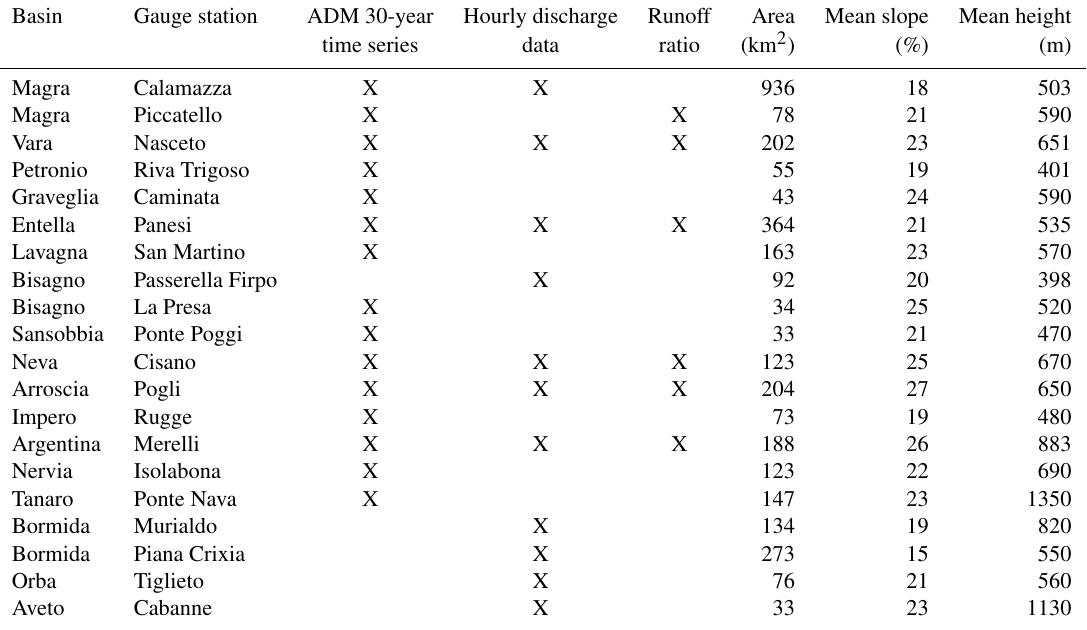
Table 1. Availability of discharge data used for model validation, ADM analysis, and long-term mass balance analysis. The characteristics of the basins upstream of each measurement station are